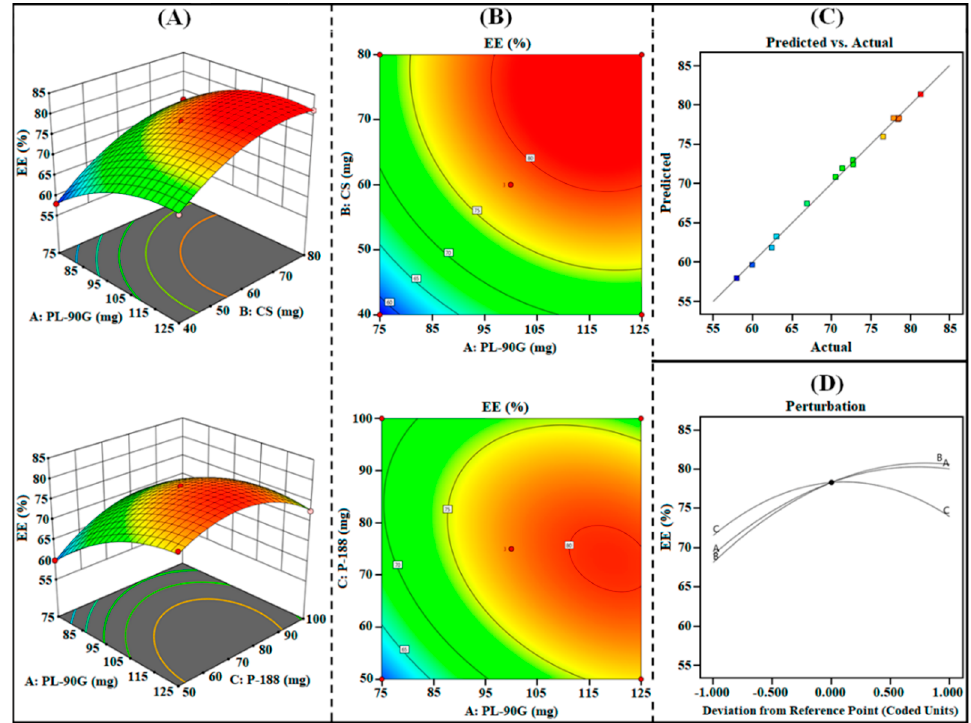
Figure 4. Image representing 3D response surface plots ( A ), contour plots ( B ), predicted vs. actual plot ( C ), and perturbation plot ( D ) representing the influence of independent factors (A = PL-90G; B = CS; C = P-188) on R 3 (%EE) for PPN-LPHNPs.